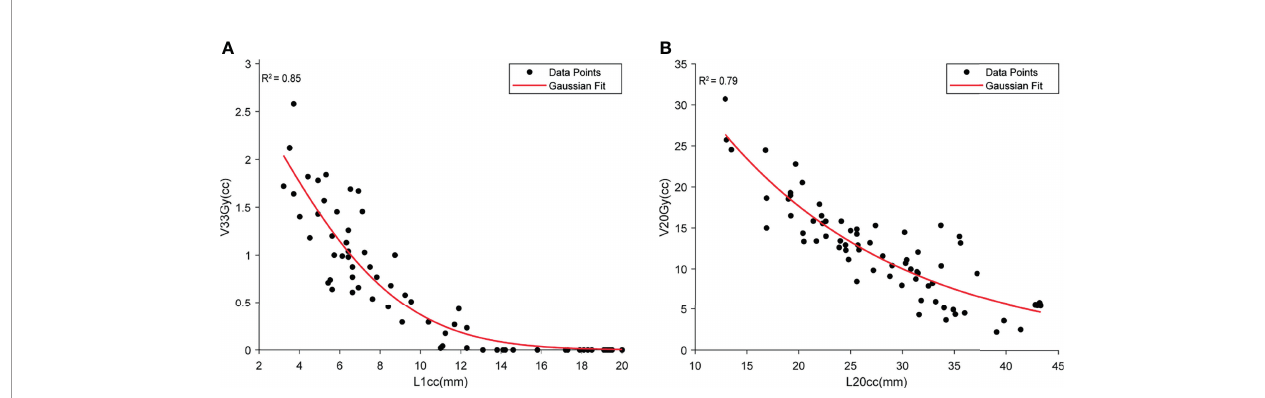
FIGURE 6 | The demonstration of the relationship between high-dose duodenal volume and L1cc (A) and low-dose duodenal volume and L20cc (B) . Both Gaussian models show a high correlation between the duodenal volume and OVH distances.